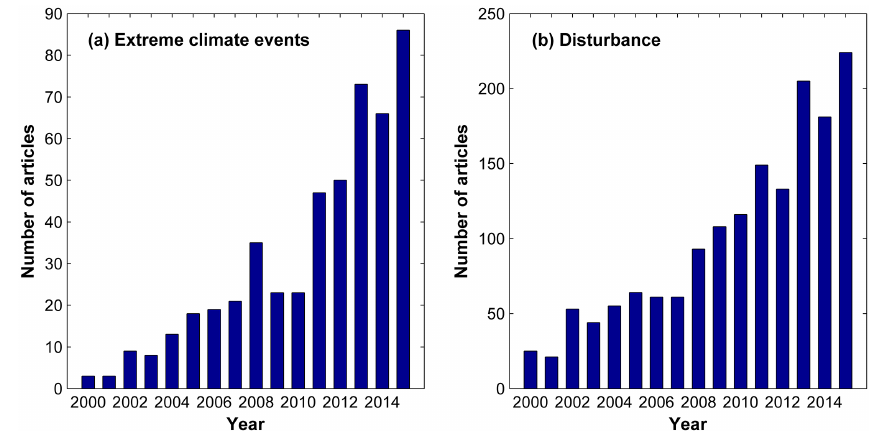
Figure 3. The number of journal articles published over the period from 2000 to 2015 as identified by Web of Science ™ as of 14 April 2016 for the impacts of (a) extreme climate events and (b) disturbance on carbon dynamics. The combination of key words that we used to represent “extreme climate events” is the following: TS = (“extreme climate events” OR “climate extremes” OR drought OR “extreme precipitation”) AND TS = (“carbon dynamics” OR “carbon cycle” OR “carbon flux” OR “carbon stock” OR “carbon pool”), where TS stands for Topic. The combination of key words used to represent “disturbance” is the following: TS = (disturbance OR fire OR harvesting OR logging OR hurricane or “insect outbreaks”) AND TS = (“carbon dynamics” OR “carbon cycle” OR “carbon flux” OR “carbon stock” OR “carbon